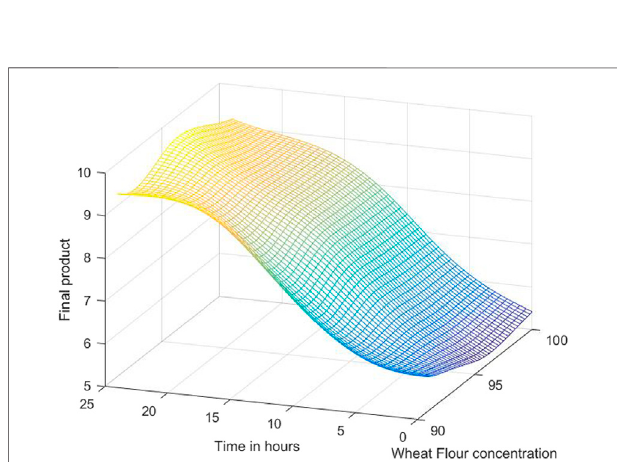
FIGURE11| 3DmodelsimulationresultswiththeLevenberg-Marquardt method and eight neurons for L. casei .